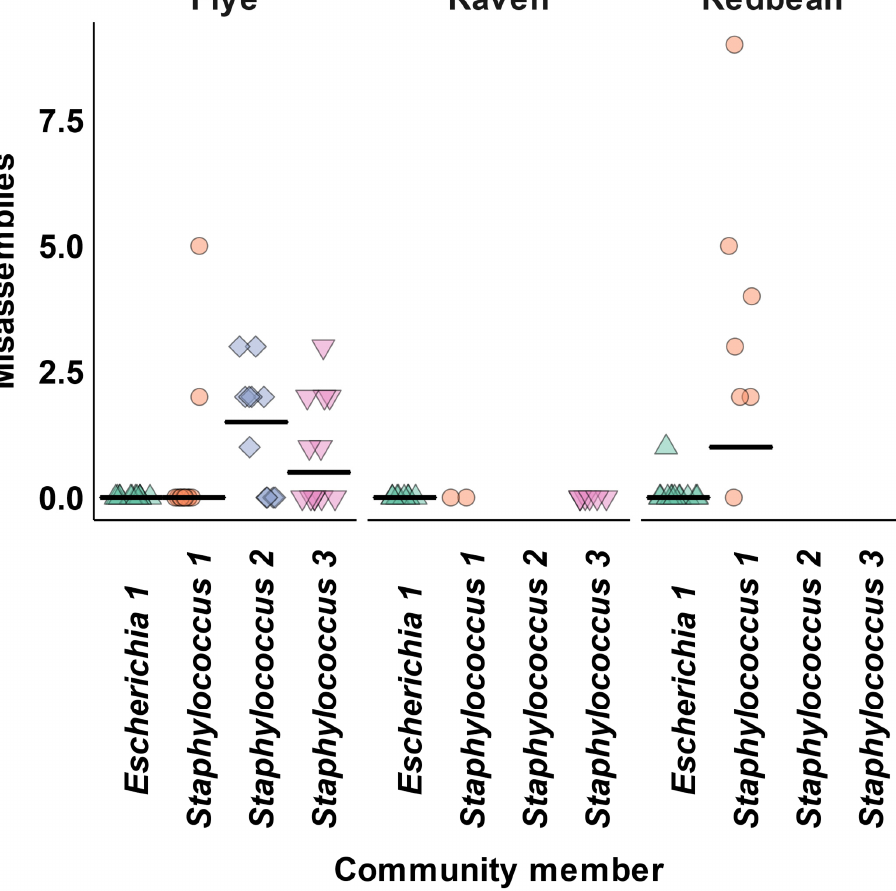
Figure A3. Plasmid misassemblies at 200 × read depth. Horizontal bars indicate the median value across replicate